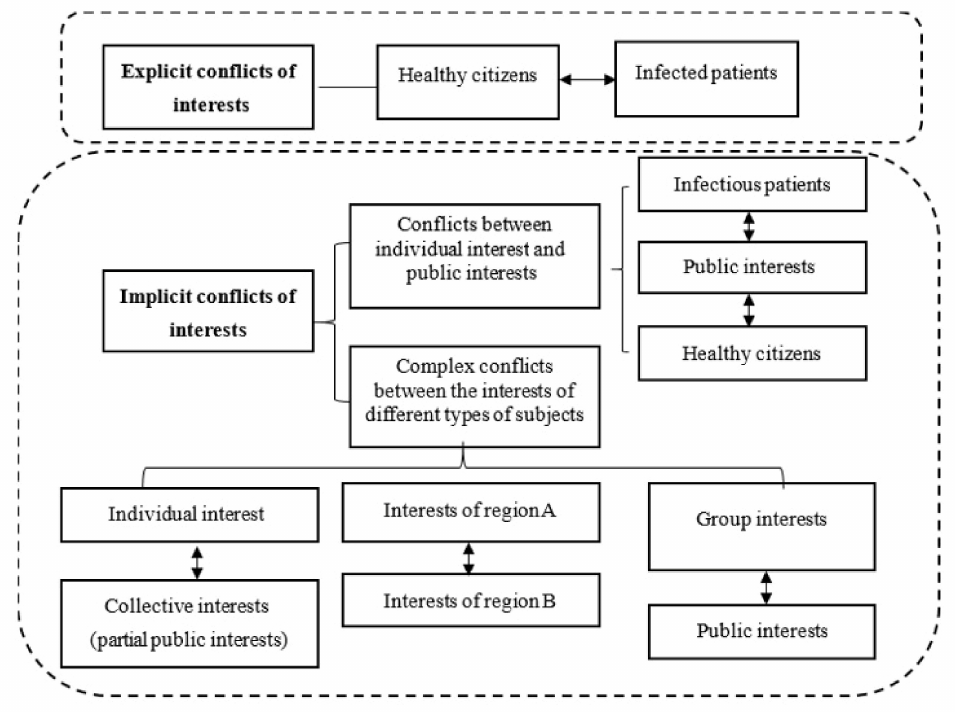
Figure 2. Conflicts of interest addressing public emerging infectious